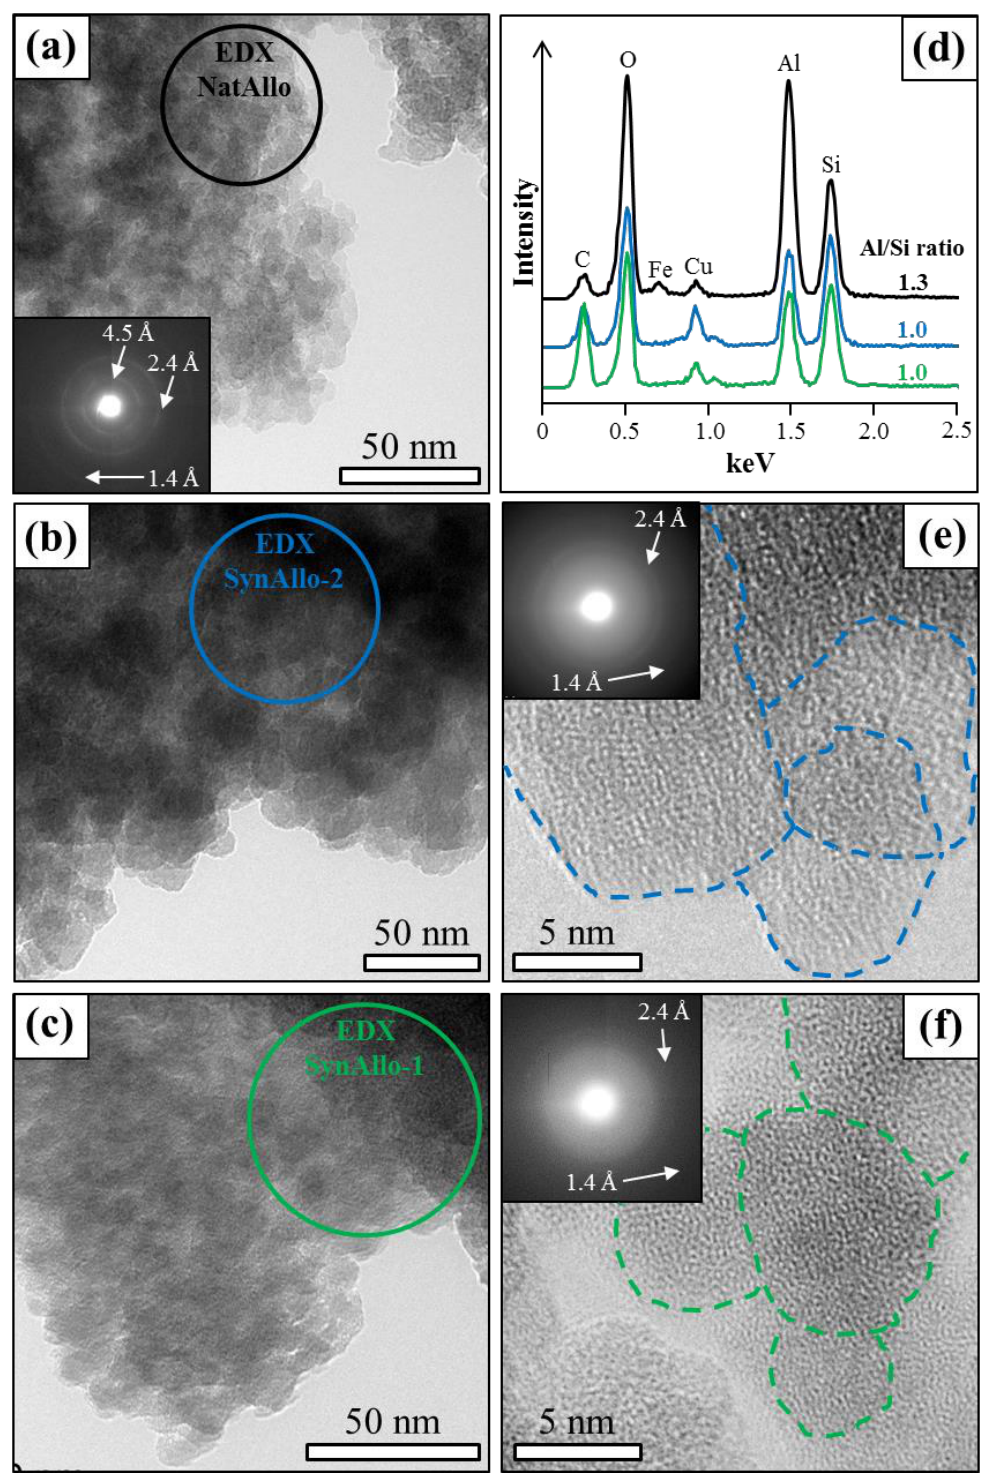
Figure 3. Transmission electron microscopy (TEM) images and selected area electron diffraction (SAED) patterns of allophane nano-particles used as adsorbents. ( a ) NatAllo; ( b ) SynAllo-2; ( c ) SynAllo-1. ( d ) TEM-energy-dispersive X-ray spectroscopy (EDX) spectra and corresponding averaged atomic Al/Si ratios of natural and synthetic allophanes (spot positions are marked in a – c ). The small Fe peak indicates the presence of goethite in NatAllo. ( e , f ) High-resolution TEM lattice fringe images and related SAED patterns of SynAllo-2 and SynAllo-1, respectively, displaying allophane “nano-ball” structures.